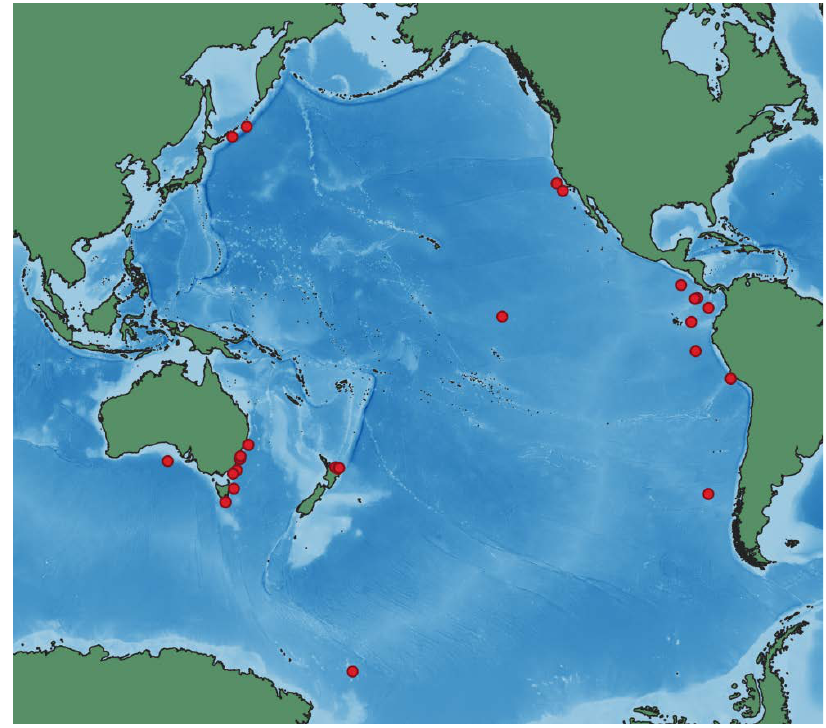
Figure 12. Global distribution of Peniagone vitrea.